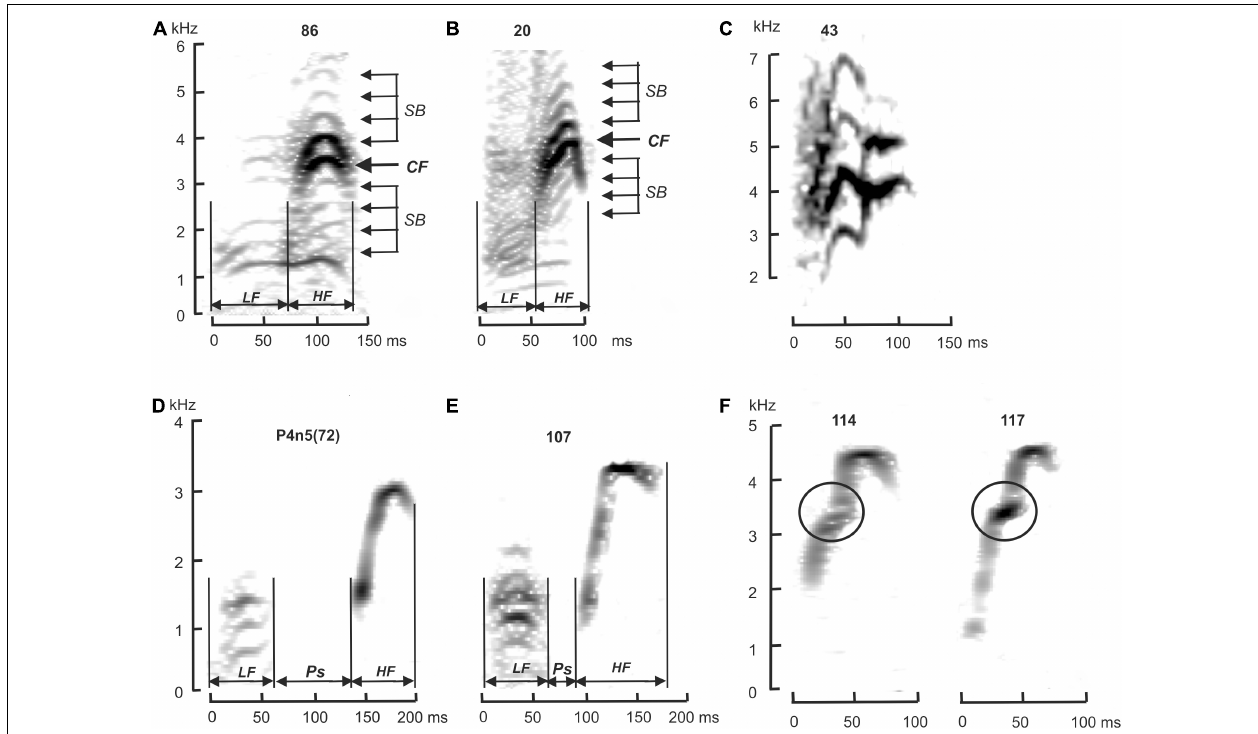
FIGURE 2 | Spectrograms of acoustic signals of M. sibirica (A–C) and M. baibacina (D–F) . (A,D) —reference populations; (B,E) —normal sound signal from Ulagchin-Gol population; (C,F) –high-frequency components of aberrant sound signals. LF , low frequency component; HF , high frequency component; Ps , pause between LF and HF ; CF , fundamental frequency; SB, sidebands. Digits above—record numbers. KHz, kilohertz; ms,